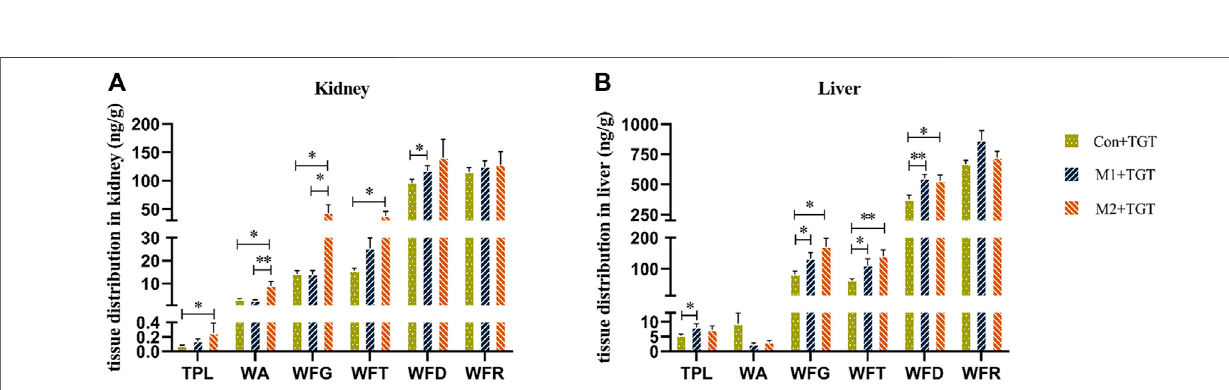
Frontiers in Pharmacology |